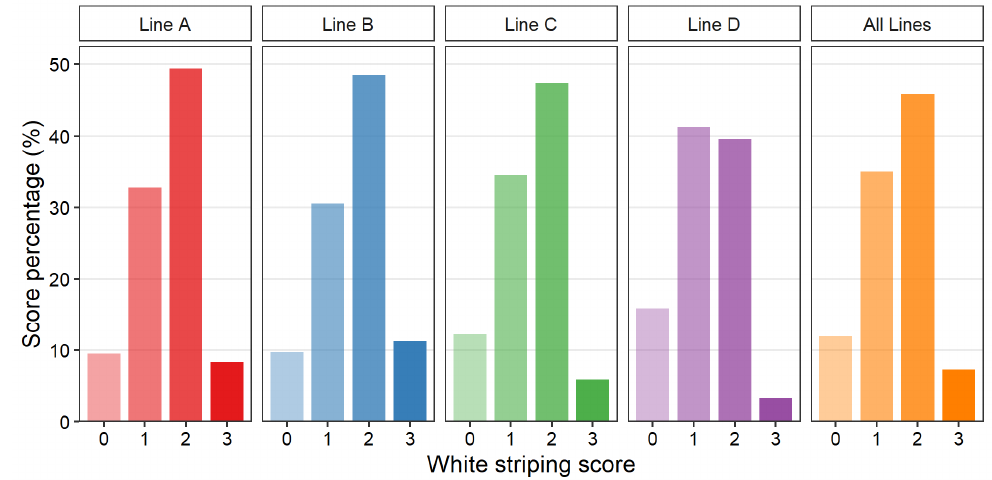
Figure 2. White striping severity score (Score 0–3 with 0 representing normal, 1 moderate, 2 severe, and 3 extreme) percentage within purebred turkey toms of each genetic line, A ( n = 2839), B ( n = 3728), C ( n = 2034) or D ( n = 3720) and within the entire studied population ( n = 12,321). Table 3. Descriptive statistics (count, mean, and standard deviation) for white striping score, slaughter weight, breast weight, and breast meat yield (BMY) for the four genetic lines of turkeys studied.